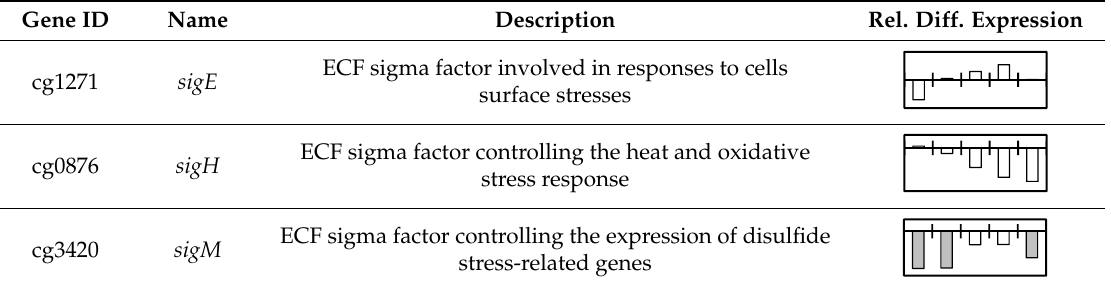
Table A2. Cont . Gene ID Name Description Rel. Diff. Expression